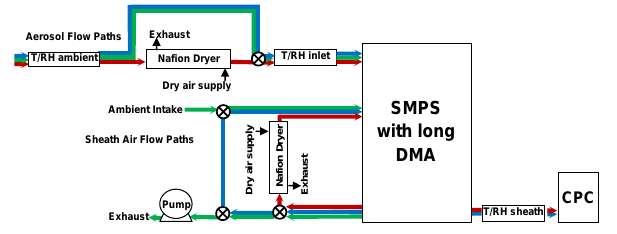
Fig. 1. Schematic of DAASS flow paths. Red is the dried sampling mode, blue is the ambient sampling mode and green is the vent mode. The internal SMPS pump for the sheath air recirculation is not shown explicitly in the